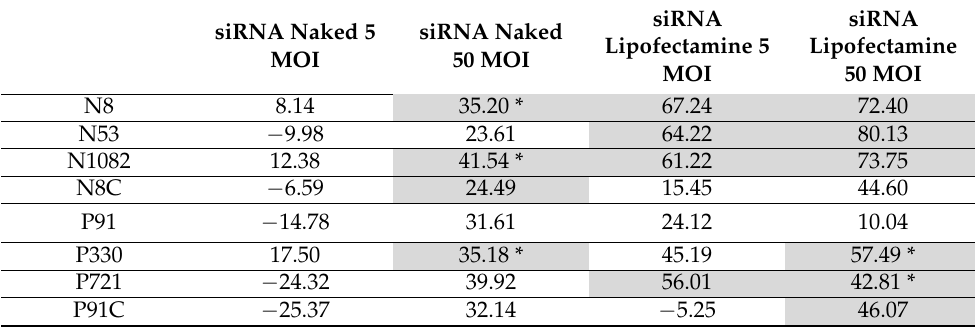
Table 3. Summary of the statistically significant mean reductions in viral RNA concentrations of RABV CVS-11 for each siRNA (both naked and using Lipofectamine for transfection) at 5 and 50